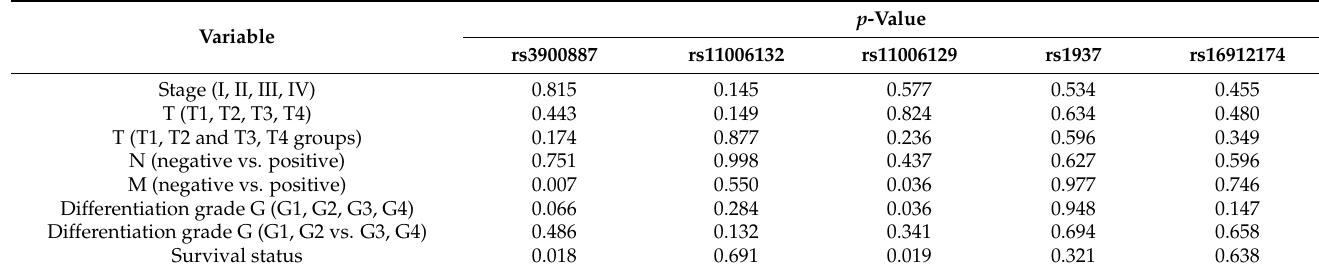
The table presents the genotype distribution within our study cohort. Gene and single-nucleotide polymorphism (SNP) rs numbers are provided. Patient count together with the genotype frequency is provided for each genotype within the cohort, together with the allele frequency for every polymorphism. * Genotype distribution is not in Hardy-Weinberg equilibrium. Table 4. TFAM gene genotype associations with disease and tumor characteristics.